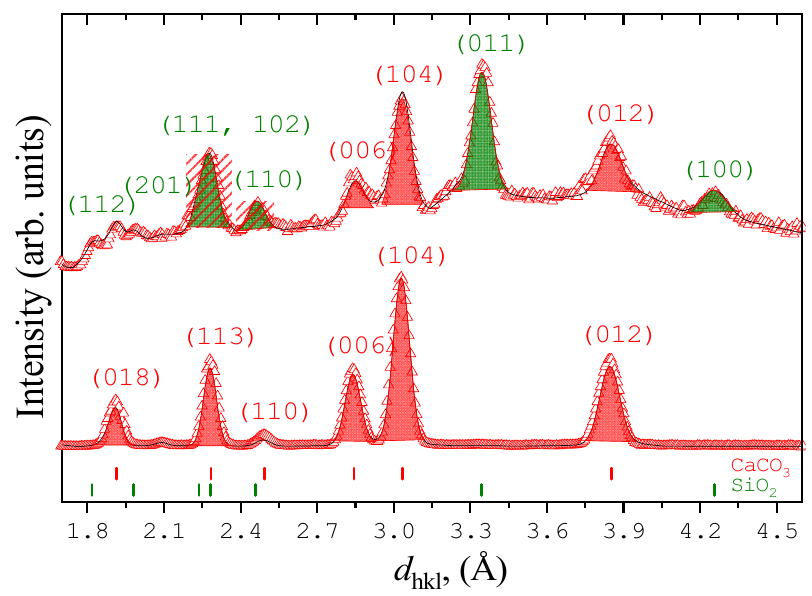
Figure 6. Neutron diffraction patterns of the mosaic fragments sample 5 (top) and sample 6 (bottom). The experimental points and calculated profile are shown. The Miller indices of major phases are labeled. Ticks below represent calculated positions of the Bragg peaks of the calcite and quartz phases. The corresponding diffraction peaks are marked.